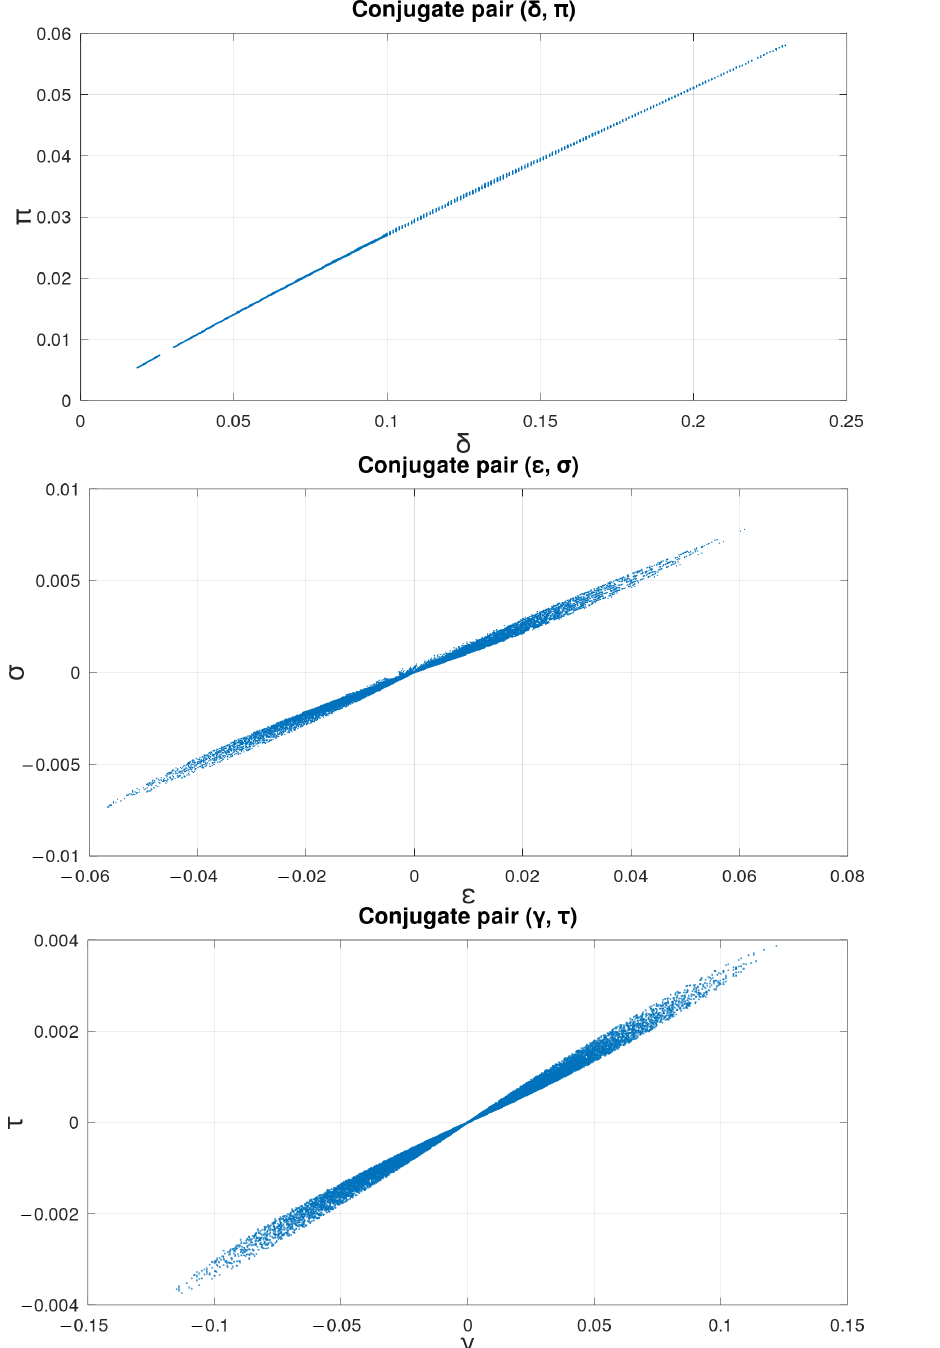
Figure 1. Virtual inflation of the neo-Hookean membrane (26). Top: ( δ , π ) pair; middle: ( (cid:101) , σ ) pair; bottom: ( γ , τ ) pair. Units of π , σ , τ are Pa · mm. The gap at the beginning is due to elimination of near-boundary triangles from the